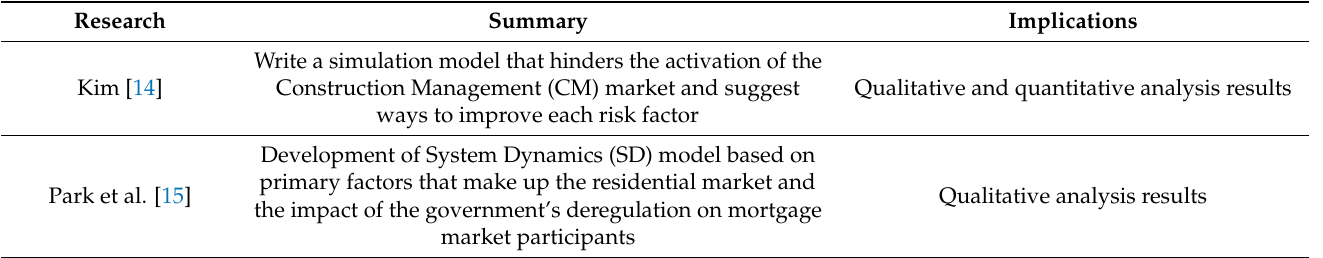
Table 1. Literature research of construction using system dynamics in